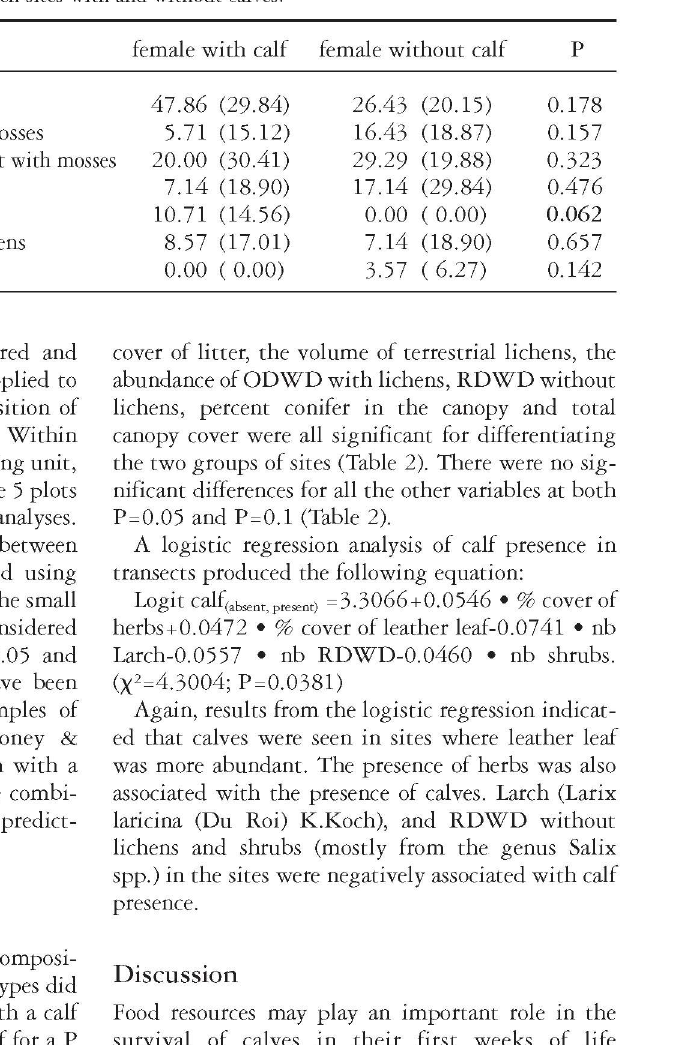
Table 1. Results of Mann-Whitney U-test at a=0.1 for differences in mean percent of forest cover types in the calving area [mean (standard deviation)] between sites with and without